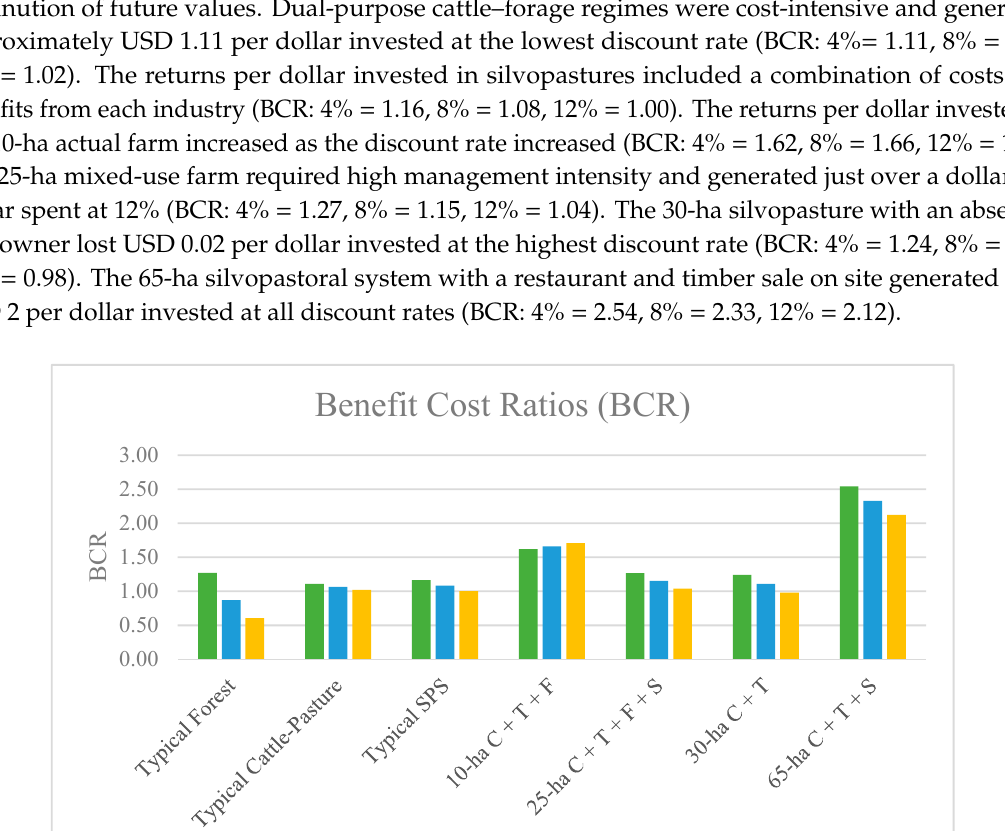
Figure 2. Annual equivalent income (AEI) of agroforestry systems.